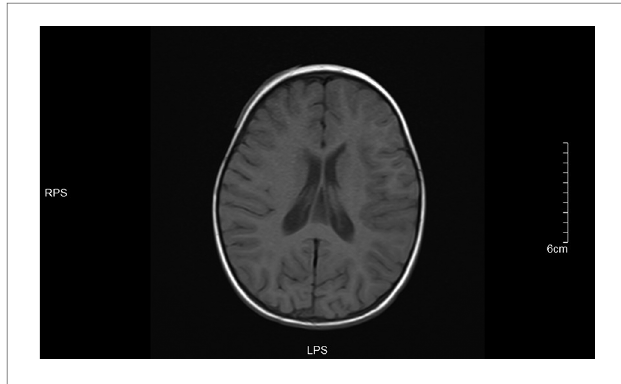
FIGURE 7 T1 left frontotemporal lobe and right temporal occipital lobe local gyri Slightly swollen.